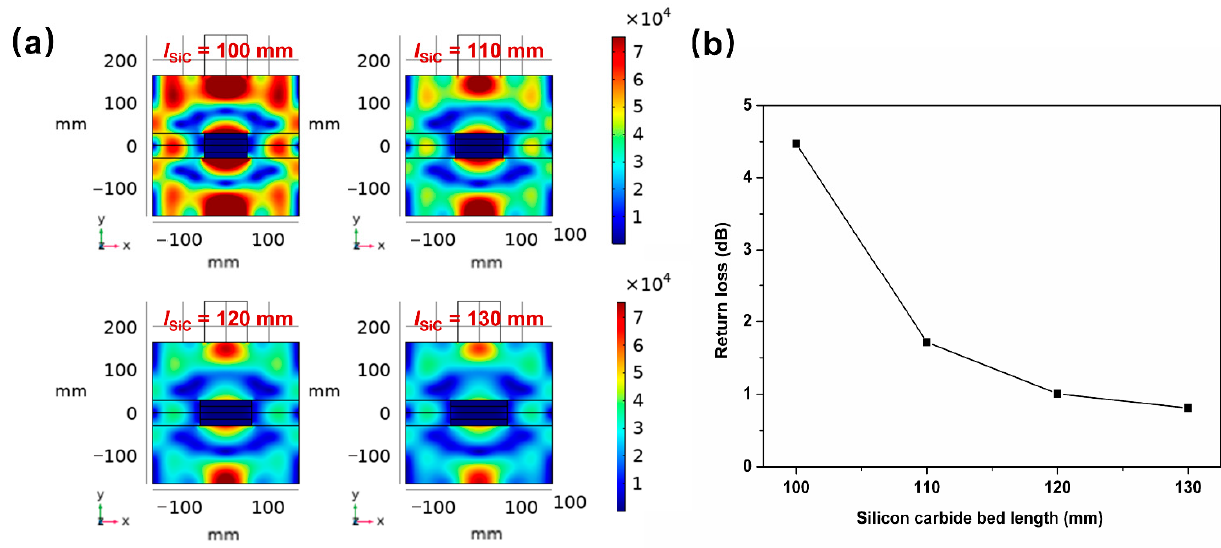
Figure 7. Effect of silicon carbide bed length on the simulated electric fields (the electric field unit: V/m; x–y plane, z = 0; z i = 5 mm; P = 1000 W; v = 0.02 m/s): ( a ) variation of the electric fields with different silicon carbide bed lengths; and ( b ) the microwave return loss with different silicon carbide bed lengths.